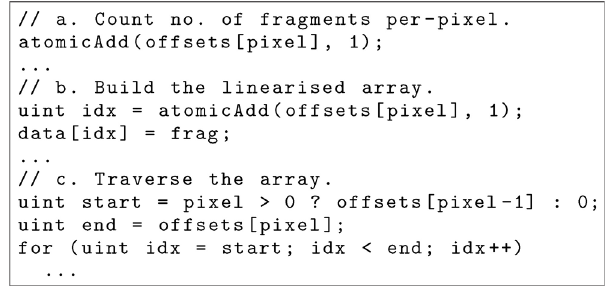
Fig. 5 Adding a fragment to and traversing a pixel’s linearised